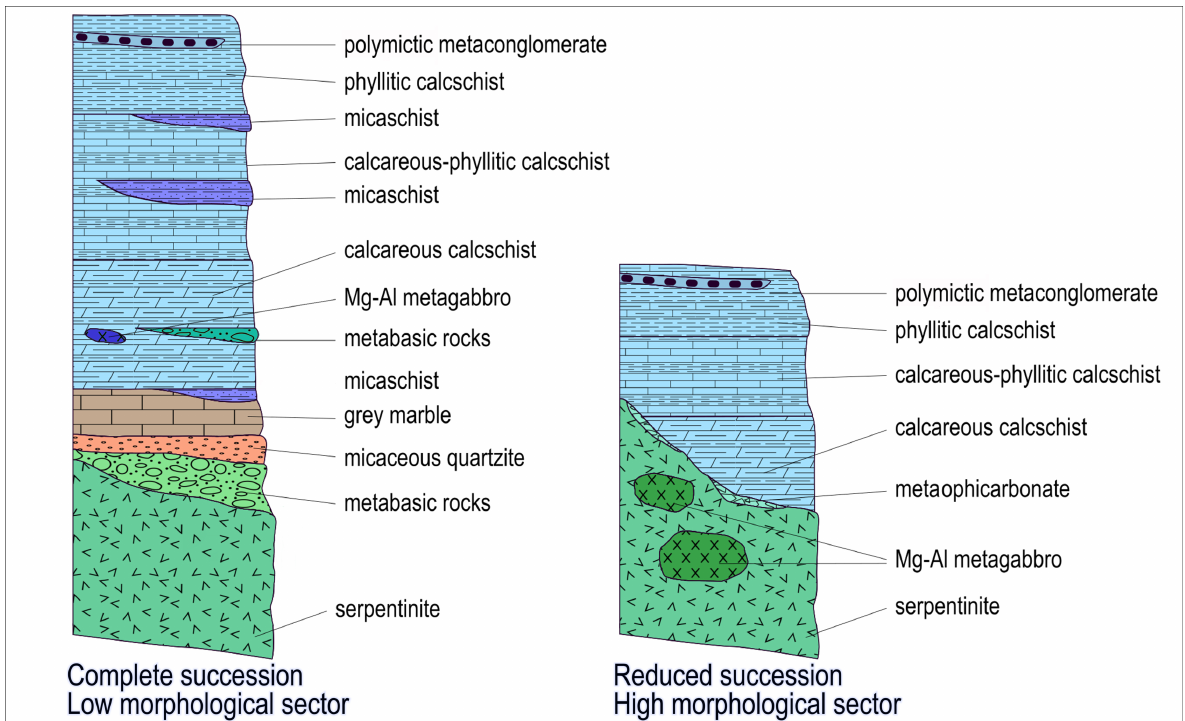
Figure 7. Stratigraphic columns of the “complete” and “reduced” successions, reconstructed from field